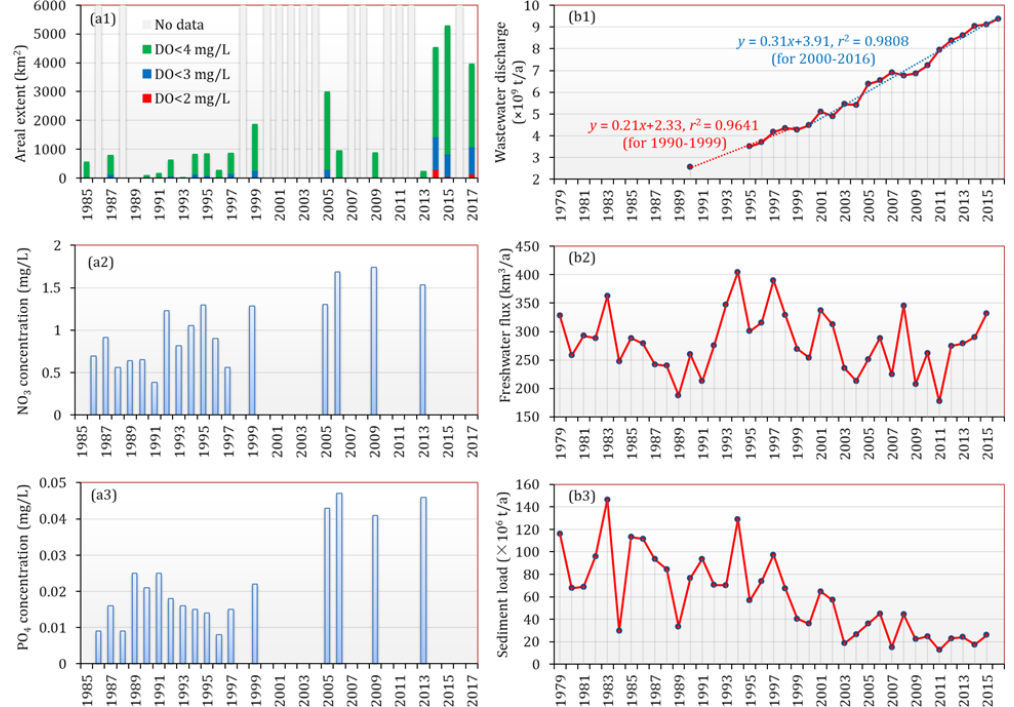
Figure 11. (a1) The estimated area extent of low-oxygen conditions in the bottom waters of the PRE (note that these results was estimated based on the data available so far and may have underestimated the actual extent in certain periods due to lack of sufficient observations) and the (a2) NO 3 and (a3) PO 4 concentrations near the four eastern outlets in summer during 1985–2017. (b1) Annual wastewater discharge in Guangdong Province during 1990–2016. The data before 1998 were taken from X. Li et al. (2020), and the remaining data were obtained from the environmental statistics bulletin published by the Department of Ecology and Environmental of Guangdong Province (http://gdee. gd.gov.cn/tjxx3187/index.html, last access: 24 September 2021). (b2) Freshwater discharge and (b3) sediment load of the Pearl River from 1979 to 2015, adopted from Wu et al.